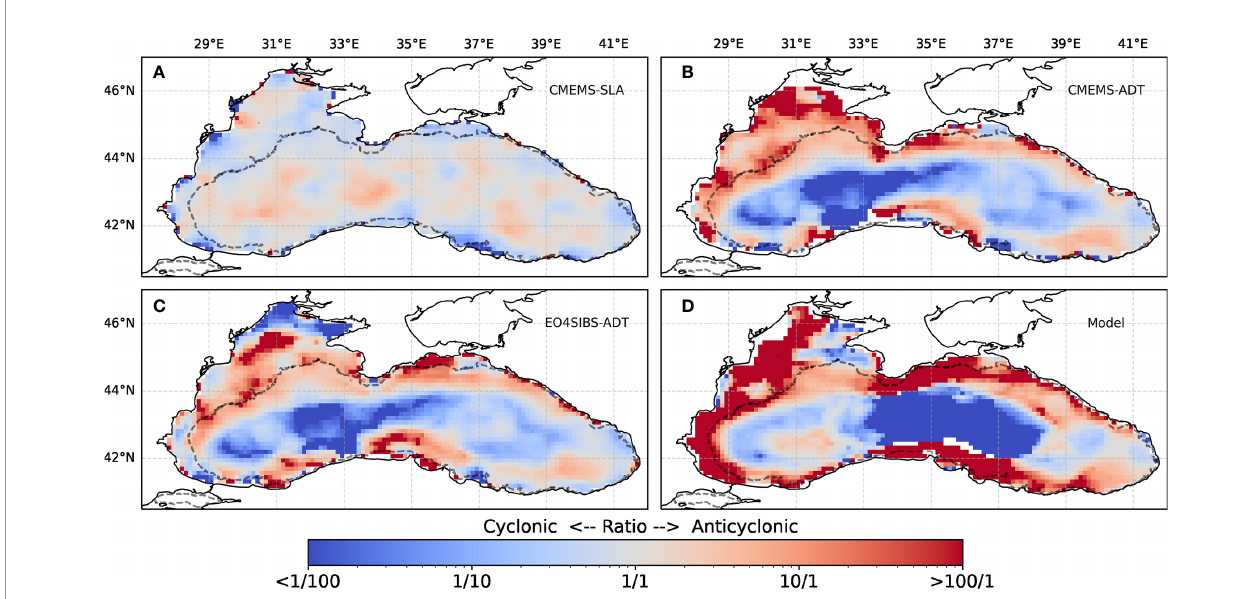
FIGURE 6 | Ratio between the number of days passed within cyclones or anticyclones, as obtained from the different data sets : (A) CMEMS-SLA, (B) CMEMS- ADT, (C) EO4SIBS-ADT, (D) Model. The dotted line indicates the 200 m isobathymetric